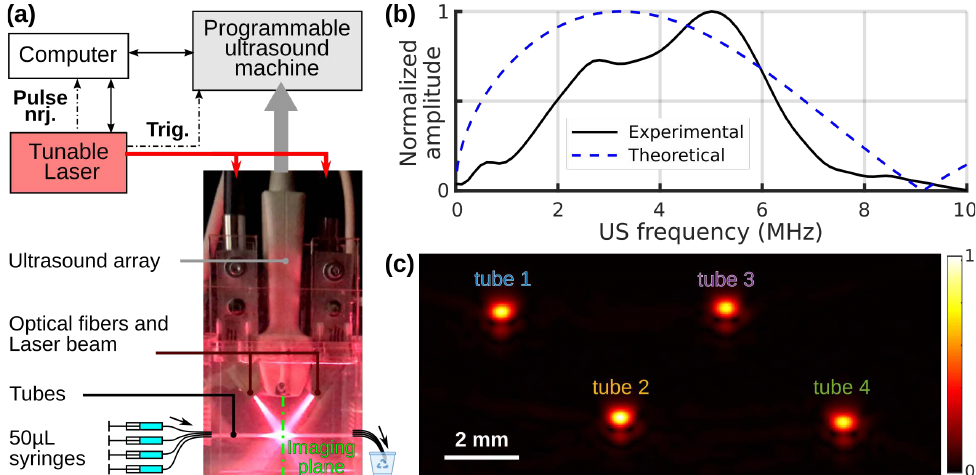
Figure 1. Experimental setup: ( a ) Annotated picture of the PAI system and schematic drawing of the experimental setup. The imaging plane of the array is perpendicular to the picture plane and perpendicular to the tubes. The laser beam was especially made visible for the picture with dust particles added in the water bath. ( b ) Experimental and theoretical frequency spectra of the PA-generated ultrasound signal. The experimental ultrasound spectrum was acquired with a tube filled with the calibration solution at 710 nm. The theoretical spectrum corresponds to Equation (A1). The spectra are normalized to their maximum values. ( c ) Image of 4 tubes filled with the calibration